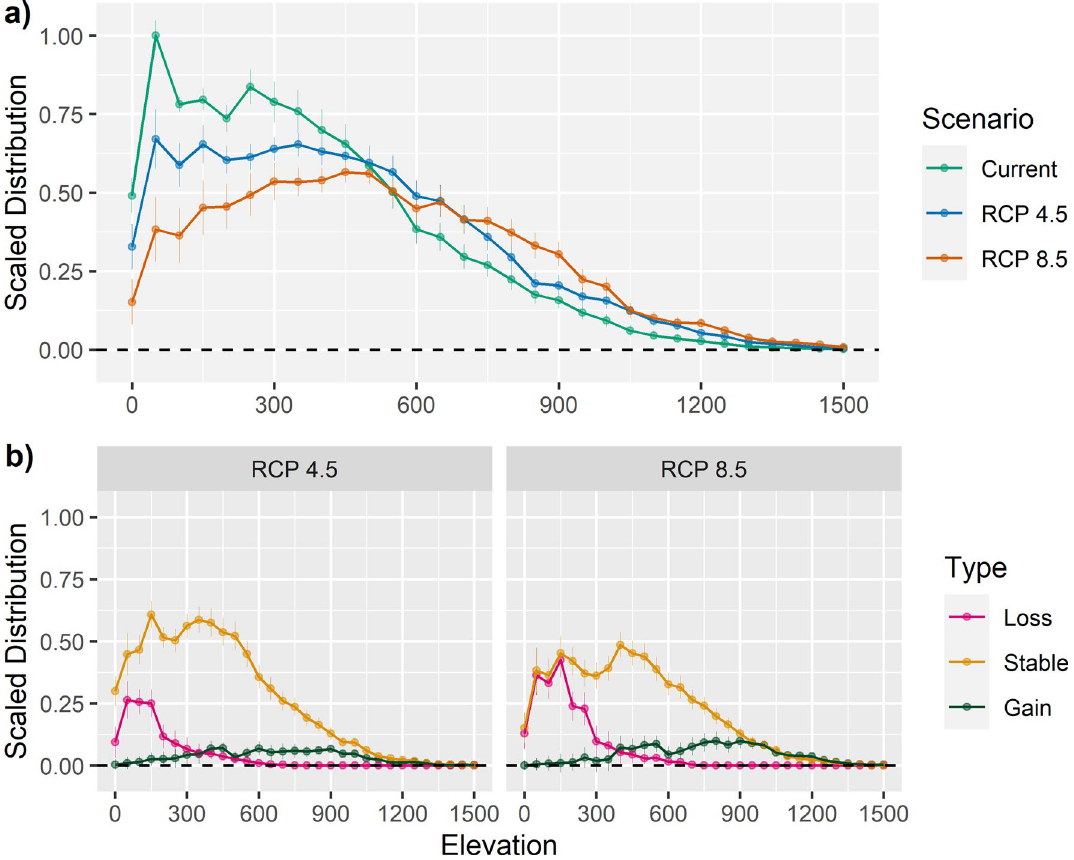
Figure 3. ( a ) The averaged scaled distribution of dipterocarps—with LCC—along an elevation gradient for the current and two future climate scenarios (RCP 4.5 and RCP 8.5 for 2070); ( b ) and changes in those distributions from current to future as loss, stable and gain, for each of the two future climate scenarios in the Philippines. Scaled distributions indicate the distribution of suitable habitat—or for any of the three potential changes in suitable habitat—across elevation bins of 50 m intervals scaled against the maximum obtained for any bin under the current climate scenario, where 1 represented the peak distribution among bins. The figure was created in R using the ggplot2 package 66,121